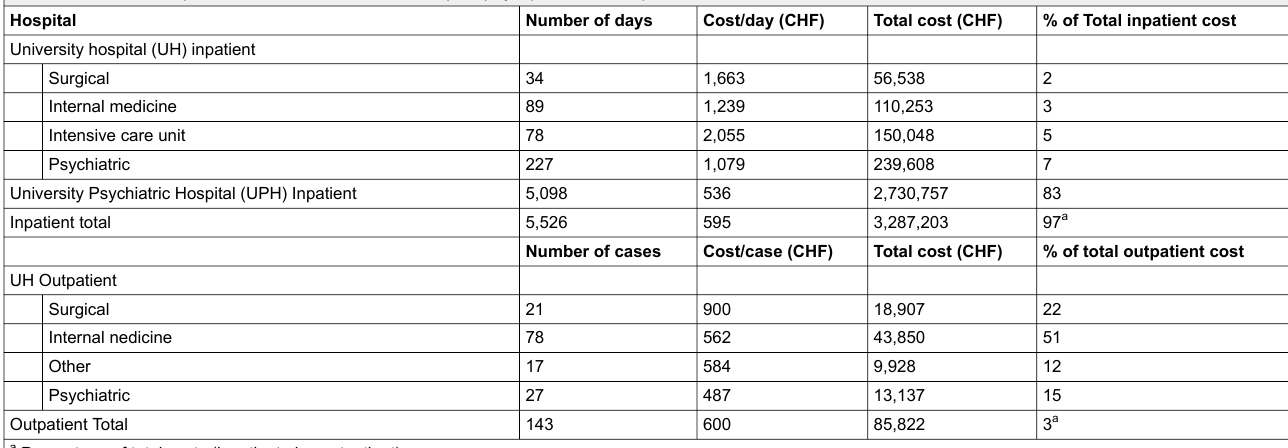
Table 2: Treatment frequencies and costs in Swiss francs (CHF) by inpatient and outpatient status.